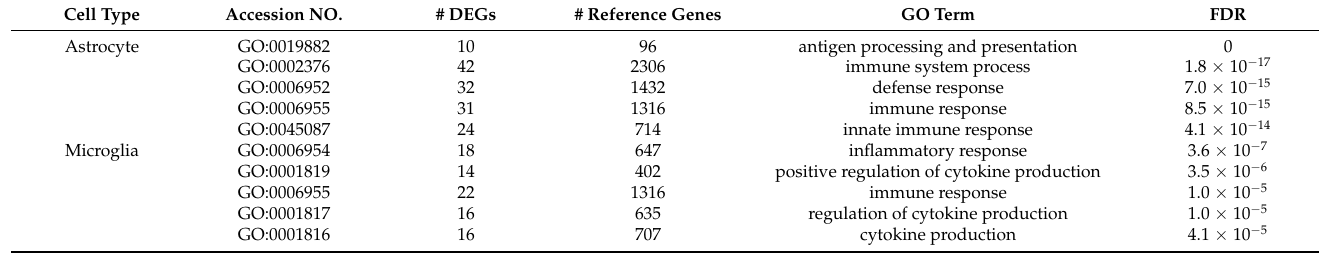
Table 1. Top five GO terms overrepresented in DEGs whose upregulation during T. gondii infection was impaired by CXCR3-deficiency. DEGs, differentially expressed genes; GO, gene ontology; FDR, false discovery rate. Cell Type